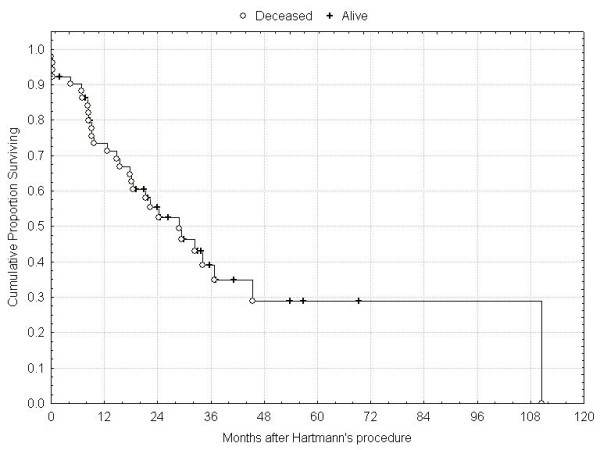
Overall survival.